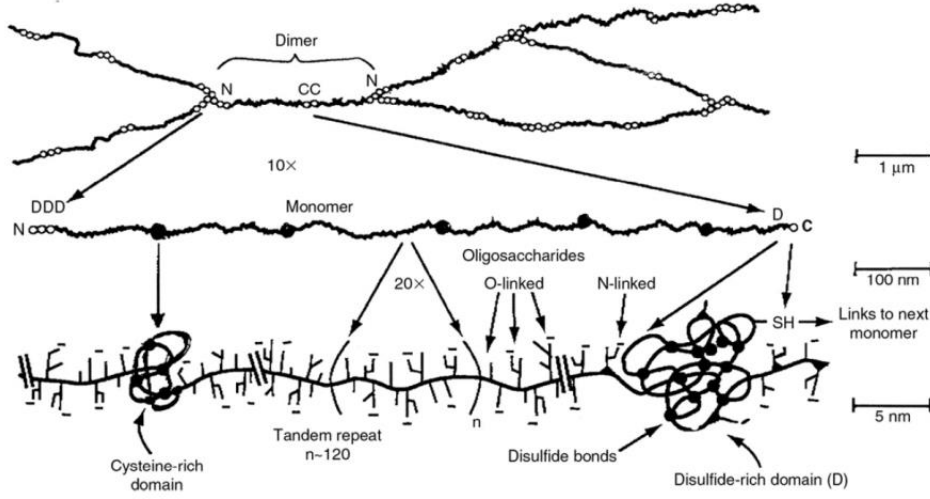
Figure 3. Representation of the crosslinking of mucins. Extracted with permission from [1].